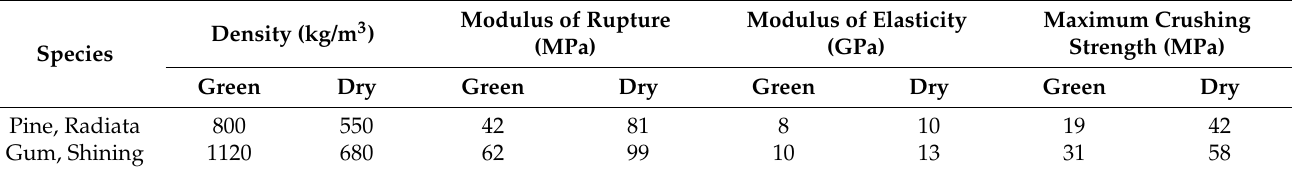
Table 1. Material properties of wood species (date taken from [36]).